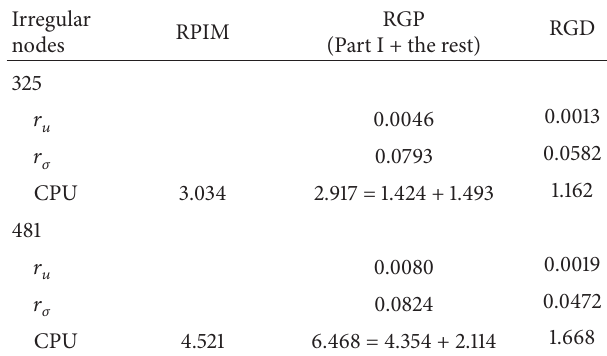
Table 2: Computational results for irregular node